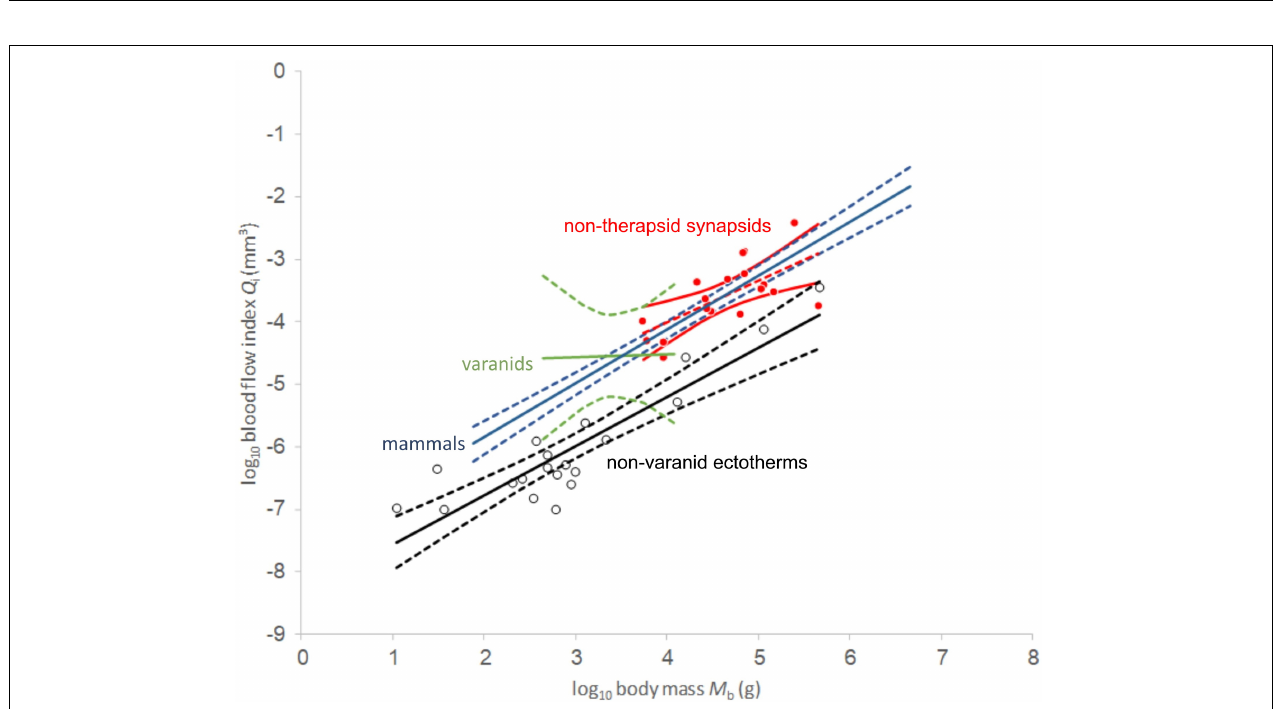
FIGURE 5 | Log-log plot of blood flow index against body mass. Red values represent non-therapsid synapsids and red dashed line represents linear least squares regression. 95% confidence of the regression mean intervals in solid red. Empty circles represent non-varanid ectotherm values. Note clustering of non-avian sauropsid values in a tight range between 100 and 1000 g body mass which causes heteroscedasticity in our PGLS analysis. Data except non-mammalian synapsids from Seymour et al. (2012).